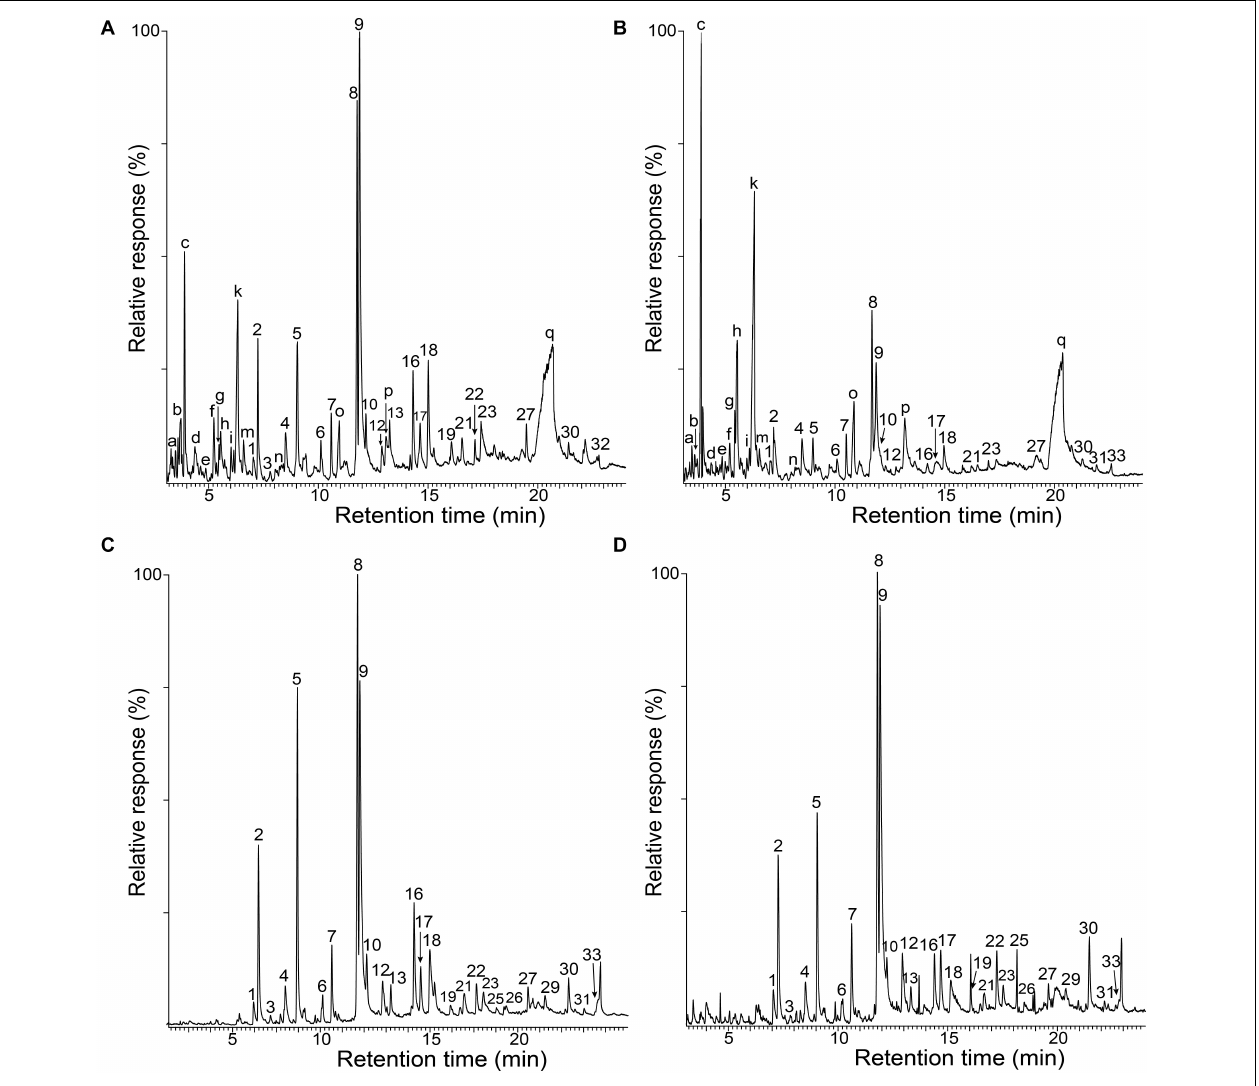
FIGURE 1 | Py-GC/MS chromatograms of the whole cell walls of rice husks (A) and rice straw (B) , and of the isolated MWLs from rice husks (C) and rice straw (D) . The identities and relative abundances of the released phenolic compounds are listed in Table 2 . Letters refer to carbohydrate-derived compounds: (a) (3 H )-furan2-one; (b) (2 H )-furan-3-one; (c) furfural; (d) 2-hydroxymethylfuran; (e) cyclopenten-1-ene-3,4-dione; (f) 2,3-dihydro-5-methylfuran-2-one; (g) 5-methyl-2-furfuraldehyde; (h) 3-ethyldihydro-2( 3H )-furanone; (i) (5 H )-furan-2-one; (k) 4-hydroxy-5,6-dihydro-(2 H )-pyran-2-one; (m) 2-hydroxy-3-methyl- 2-cyclopenten-1-one; (n) 3-hydroxy-2-methyl-(4 H )-pyran-4-one; (o) 5-hydroxymethyl-2-tetrahydrofuraldehyde-3-one; (p) 5-hydroxymethyl-2-furfuraldehyde; (q)